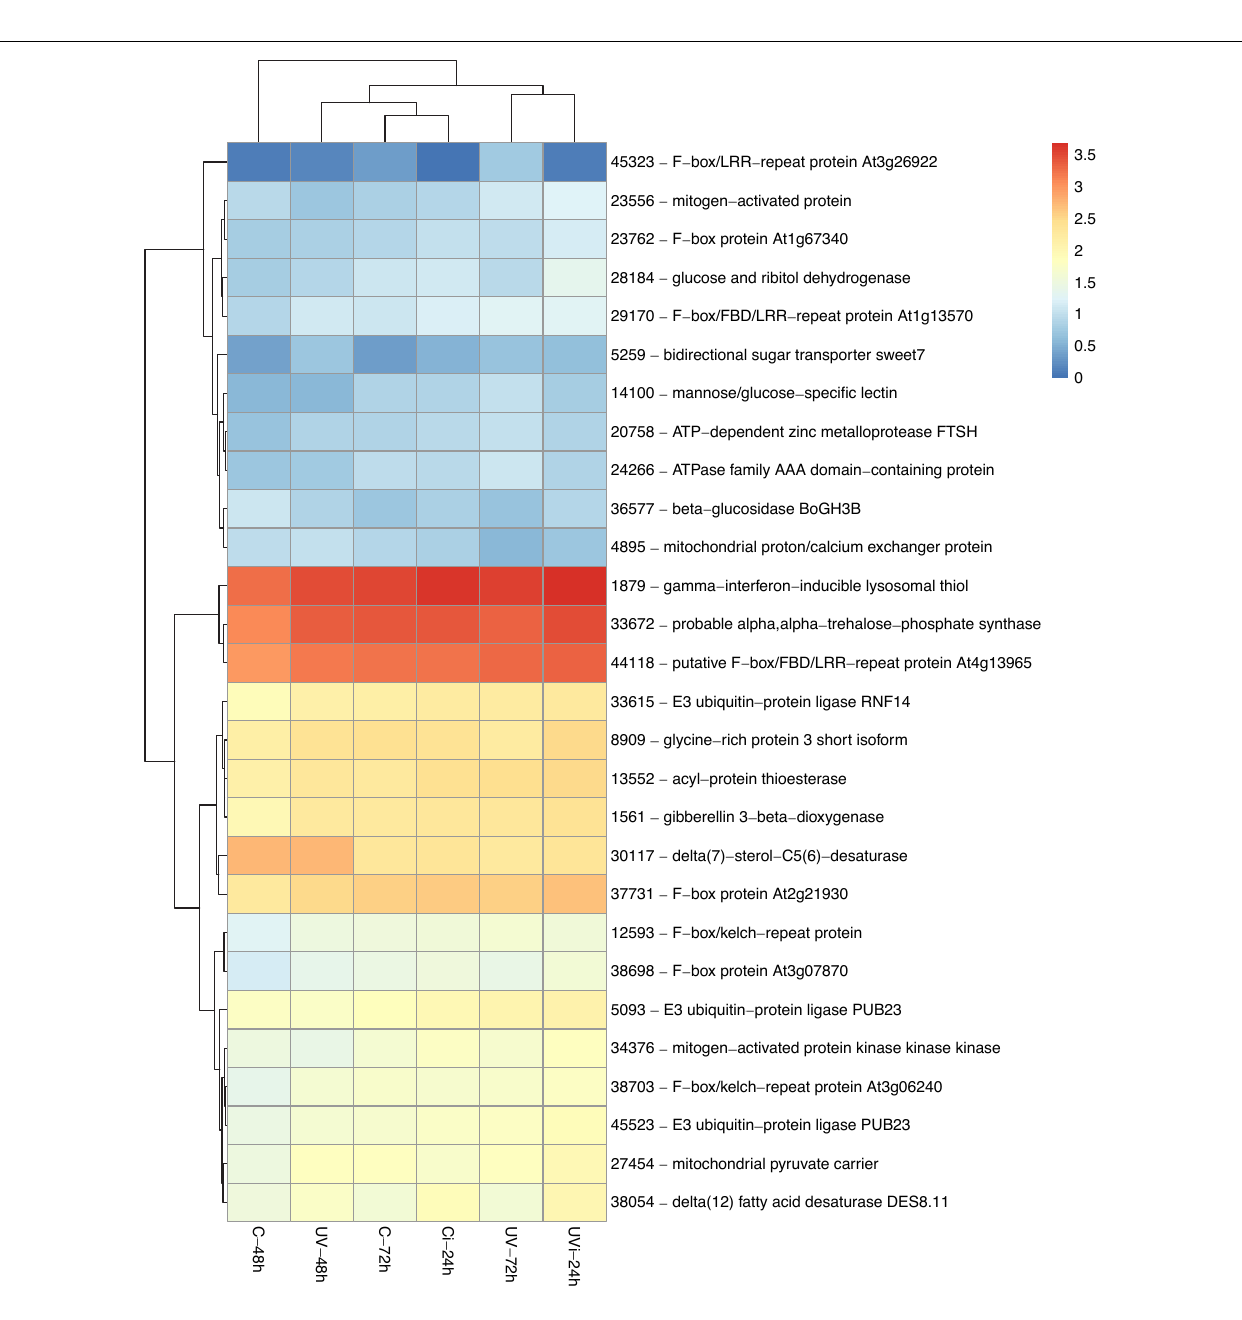
FIGURE 3 | Primary metabolism-related genes differentially expressed in response to the influence of UV and Xcv inoculation. Test of hierarchical DEG (HCA) groupings. The colors reflect the level of relative gene expression. The columns and rows represent the samples and ID_genes associated with the name/function of the corresponding protein that were grouped according to their relative expression profile, respectively. C-48 h, control corresponding to treated 48 h after UV; UV-48 h, UV after 48 h treatment; C-72 h, control corresponding to treated 72 h after UV; UV-72 h, UV after 72 h treatment; Ci-24 h, control 24 h after inoculation; UVi-24 h, UV 24 h after inoculation. The genes were filtered out with a threshold |log2-FC| > 1.5 and FDR <